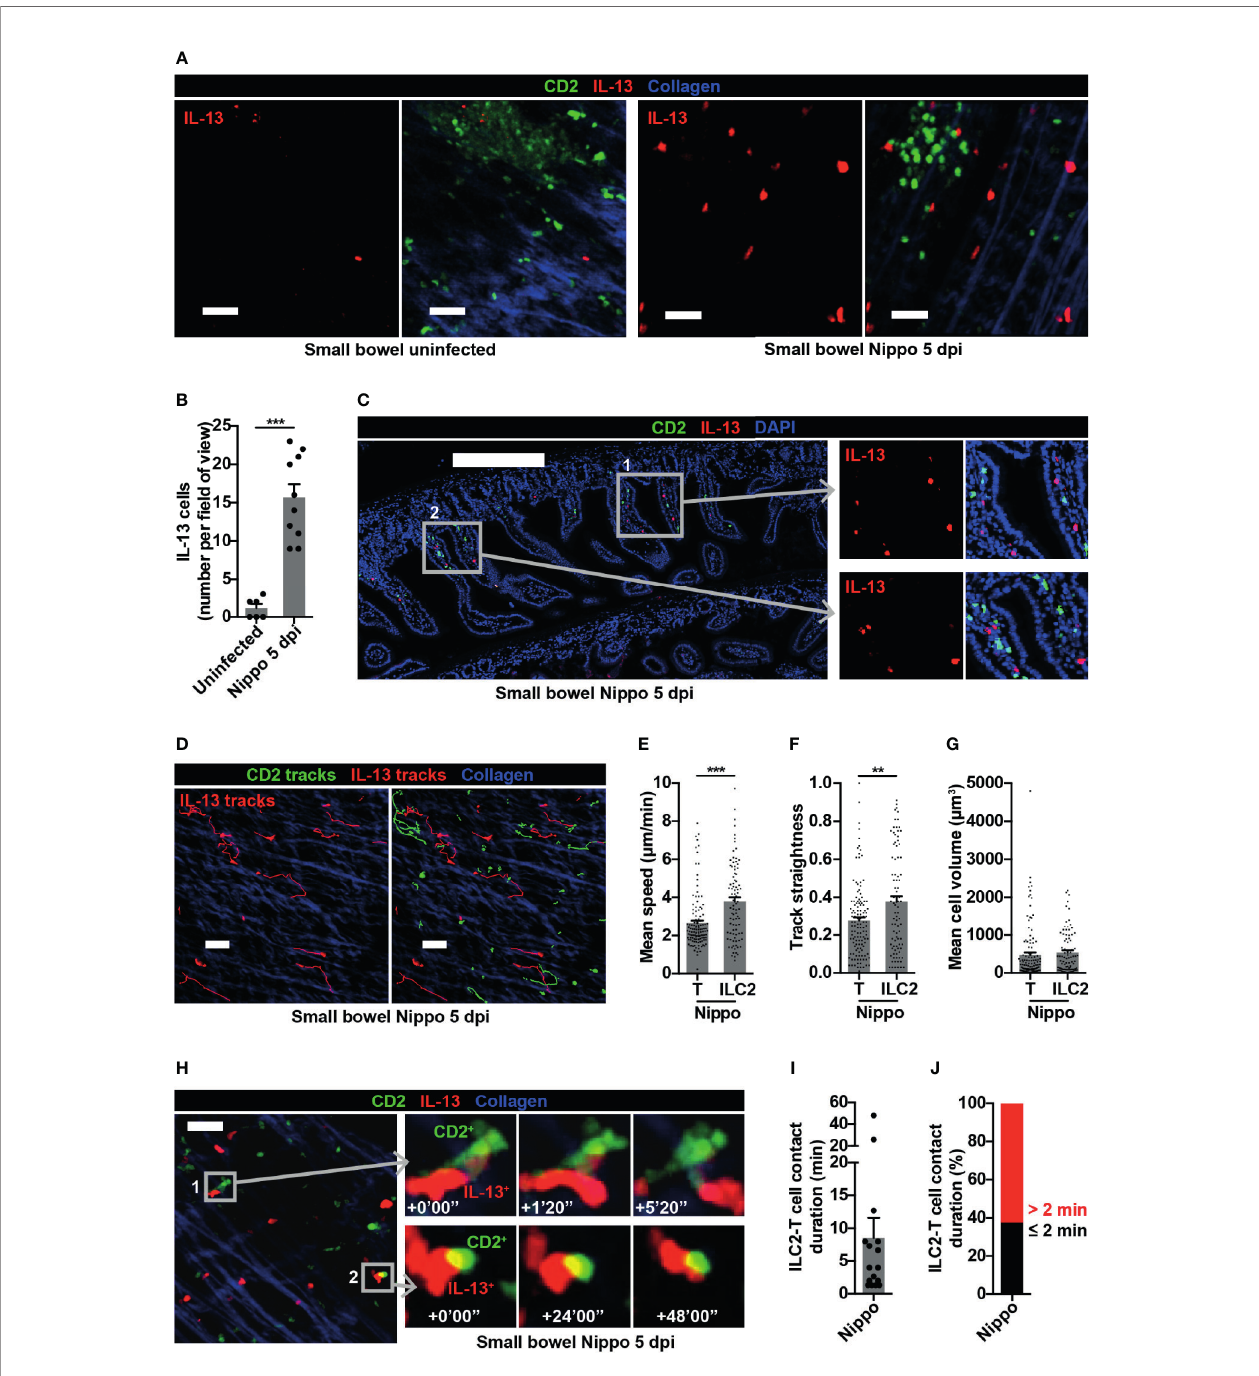
FIGURE 5 | Small bowel ILC2s show altered movement and interact with T cells following helminth infection. (A) Intravital images of small bowel ILC2s, uninfected and Nippo 5 dpi; scale bar 50 µm, Z 16-30 µm. (B) Quanti fi cation of ILC2 numbers per fi eld of view; *** p < 0.001. Pooled data from 4 movies from 1-3 mice per condition, each dot representing one fi eld of view. (C) Stitched image of small bowel 5 dpi showing location of CD2 + and IL-13 + cells; scale bar 300 µm, Z 2 µm. (D) Intravital image showing ILC2 and T cell tracks in small bowel 5 dpi; scale bar 50 µm, Z 30 µm. (E – G) Quanti fi cation of (E) mean speed, (F) track straightness and (G) mean cell volume of small bowel ILC2s and T cells 5 dpi; ** p < 0.01, *** p < 0.001. Pooled data from 3 movies, each dot representing one cell track. (H) Intravital examples of ILC2-T cell interaction in small bowel 5 dpi; scale bar 50 µm, Z 26 µm. (I, J) Quanti fi cation of (I) ILC2-T cell contact duration (min) with each dot representing one interaction, and (J) proportions of ILC2-T cell contacts > 2 or ≤ 2 minutes in small bowel 5 dpi. Pooled data from 3